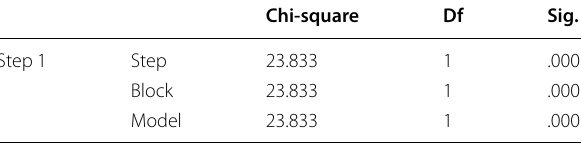
Table U. Omnibus Tests of model coefficients for attention to details culture